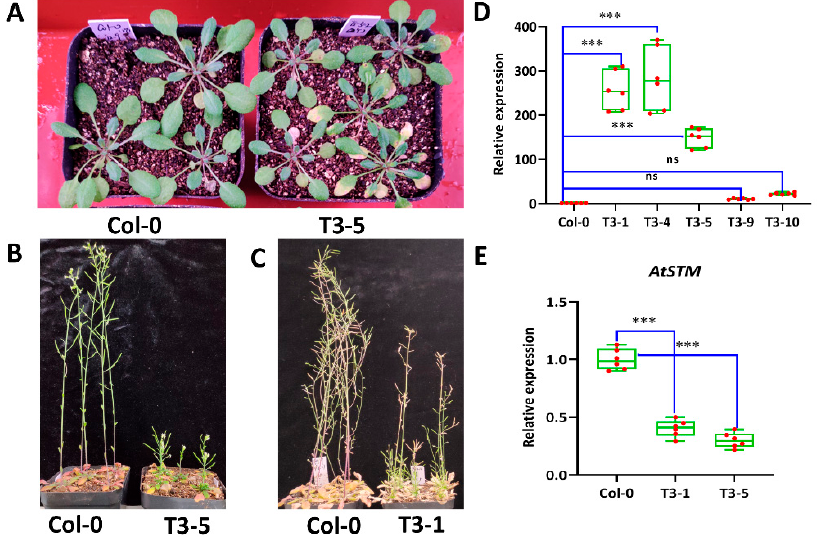
Figure 6. Overexpression of ScCaM in Arabidopsis thaliana . ( A ). Phenotypes of 3-week-old plants of the transgenic line (T3-5) and the wild type (Col-0). ( B ). Phenotypes of 6-week-old plants of the transgenic line (T3-5) and the wild type (Col-0). ( C ). Phenotypes of 9-week-old plants of the transgenic line (T3-5) and the wild type (Col-0). ( D ). The transcripts of ScCaM in the transgenic Arabidopsis thaliana . ( E ). The transcripts of AtSTM in the Arabidopsis thaliana of the transgenic line (T3-5) and the wild type (Col-0). AtACT2 was used for the normalization of the transcript levels. Asterisks indicate a significant difference, as determined by a one-way ANOVA (treatment: WT/transgenic), followed by Duncan’s new multiple range test (ns indicates no significant difference, *** p <0.01). The F-statistics, degrees of freedom, and p -value for each factor or interaction are shown in Tables S4 and S5.